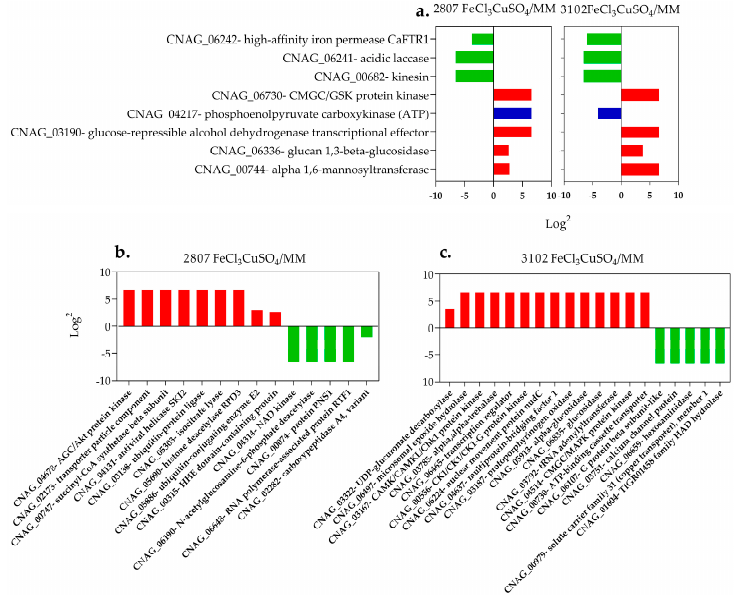
Figure 7. Proteins ( n = 41) considered differentially abundant related to the capsule, melanin, and other virulence factors ( a ) Proteins common to both isolates. ( b ) exclusive proteins found in 2807 isolate and ( c ) in 3102 isolate. In red, up-regulated proteins; in green, down-regulated proteins; and in blue, those that presented opposite abundances between the two isolates.